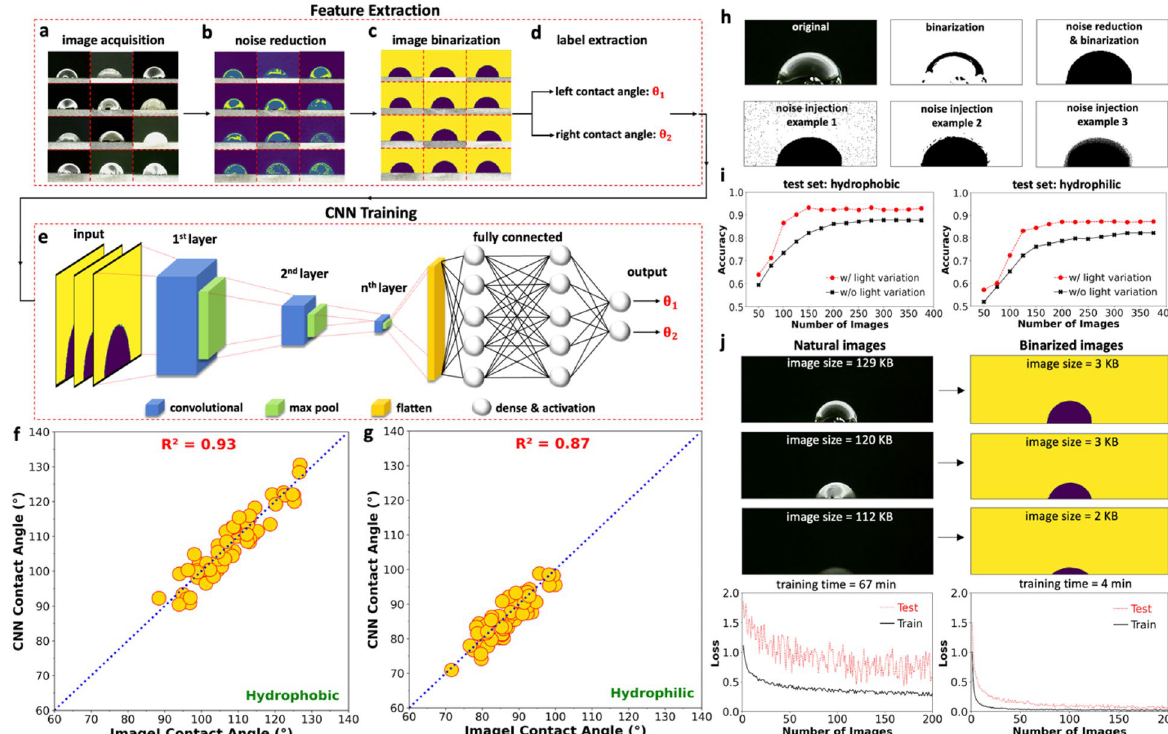
Figure 3. Workflow for feature extraction and training the CNN model: ( a ) acquiring natural front-lit drop images in a dark room, ( b ) denoising the images using a filter in Python, ( c ) converting the multi-tone to bi-tonal (binary) images to better distinguish the overall geometry of drops, ( d ) estimating the left and right CAs of each drop using the Point Picker plugin in ImageJ to create the ground truth dataset, and ( e ) designing an nth layer CNN framework to estimate the left and right CAs, ( f ) matching the CNN with the ImageJ CA estimations on hydrophobic, and ( g ) hydrophilic surfaces. ( h ) Top row: noise reduction filter on natural images to create ground truth binary images prior to the training step, bottom row: three different examples of noise injection filter on binary images during the data augmentation step, ( i ) accuracy of the CNN model as a function of the number of unique training images (solid black line) for hydrophobic (left subplot) and hydrophilic (right subplot) test sets, in which the 9 variations in the lighting conditions (red dashed line) has proven to improve the accuracy and stability of results, and ( j ) estimating the performance of the CNN model on natural (left column) or binarized (right column) images proving that binarizing the input data would reduce the training time and improve the accuracy/stability of the CA